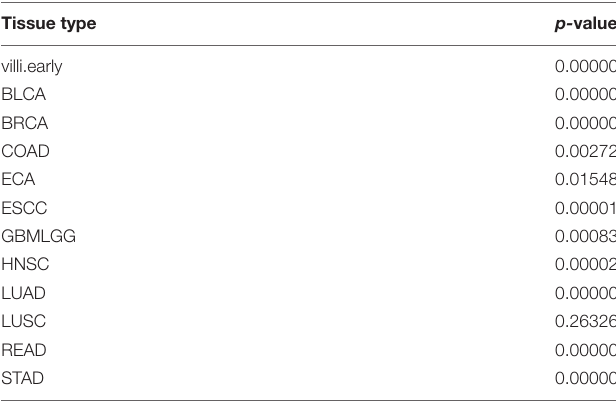
TABLE 2 | The p- value enriched by EMT in villi and 11 cancers.